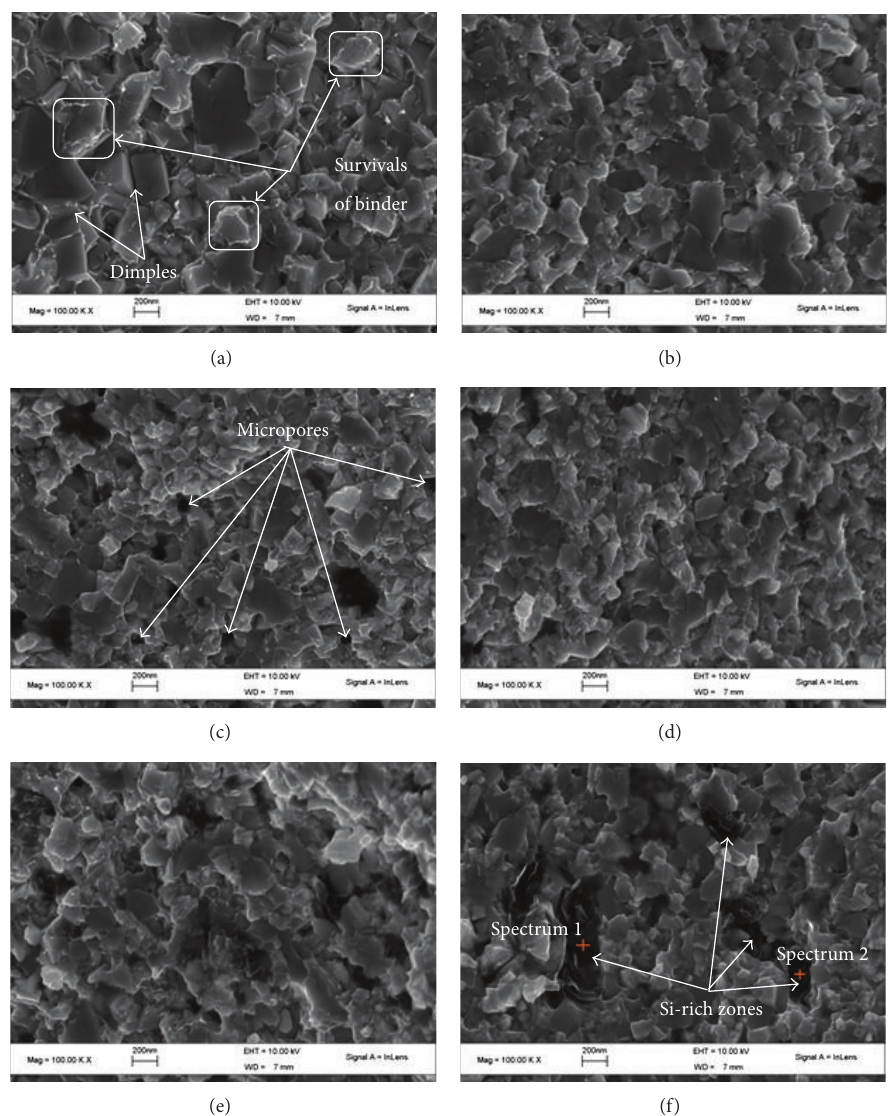
Figure 3: Typical SEM micrographs on the fractured surfaces of the prepared WC-Ni cemented carbides with varied fractions of SiC nanowhisker: (a) 0wt.%, (b) 0.75 wt.%, (c) 1.5 wt.%, (d) 2.25 wt.%, (e) 3.0 wt.%, and (f) 3.75